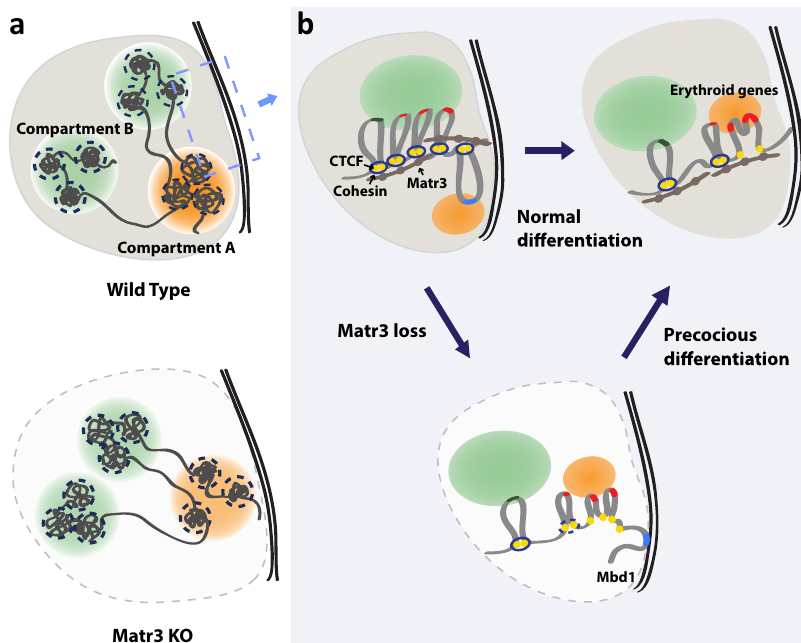
Fig. 8 Matr3 maintains chromatin structure and coordinates regulation of gene expression and differentiation. a Matr3 is required to organize chromosomal structure and maintain compartmentalization. The strength of interactions between the B compartments (green) became stronger whereas the contacts between the A-type domains (orange) were reduced in Matr3 KO cells. In the local chromatin compaction within the TADs indicated by the dashed circles, the intra-TAD contact frequency between compartment B were decreased while the interaction frequency between compartment A increased. b The region of the left dashed box is shown on the right. Matr3 interacts with CTCF and cohesin, and Matr3 loss destabilizes their binding to a subset of chromatin regions, which is necessary for proper gene regulation (e.g. Mbd1, marked in blue). The resulting altered chromatin structure resembles that of more differentiated cells and appears to accelerate cell maturation by modulating regulatory regions more accessible. Differentiation- speci fi c erythroid genes are shown in